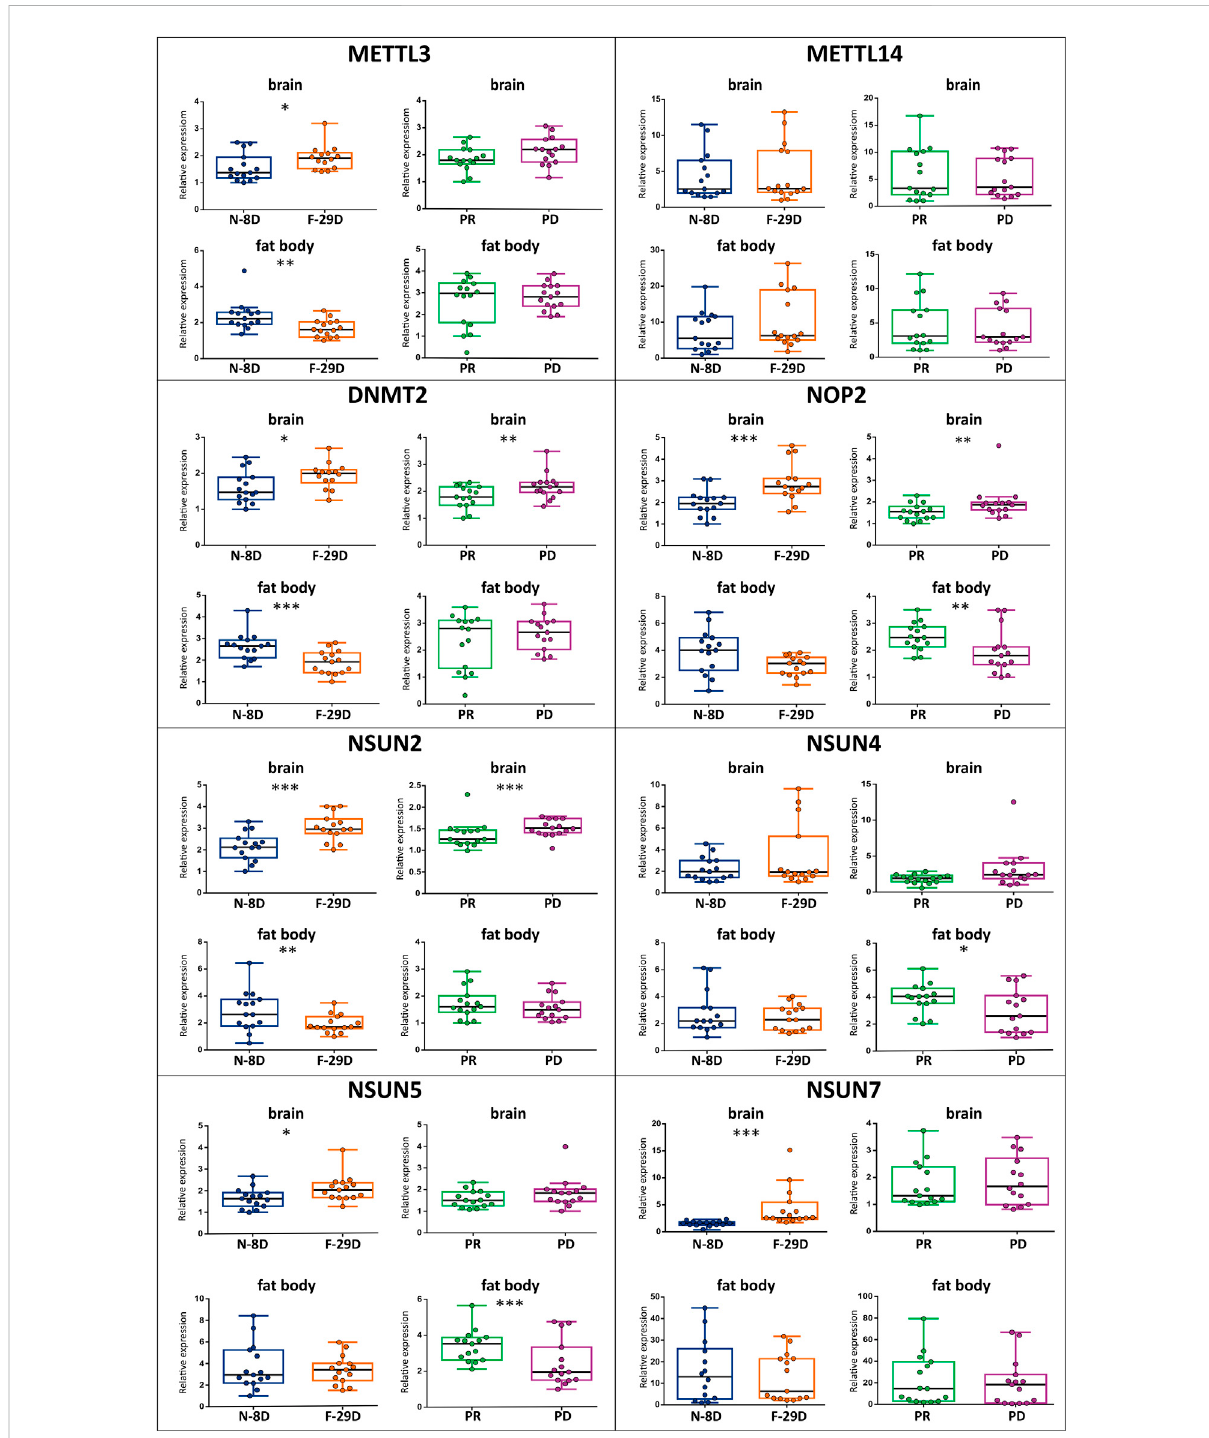
FIGURE 1 Relative expression of m 6 A (METTL3 and METTL14) and m 5 C (DNMT2, NOP2, NSUN2, NSUN4, NSUN5, and NSUN7) RNA methyltransferase genes, measured by real-time PCR in the brain and fat body samples from workers of different ages/behaviors (N-8D for 8 days-old nurses – blue — and F-29D for 29 days-old foragers – orange) and under different dietary regimes (PR for pollen-rich diet – green — and PD for pollen- deprived – purple), n =15percondition.Theboxplotsrepresenttheminimum,maximum,andmedianvalues.Thepresenceofasterisksindicates a signi fi cant difference in expression, * p < 0.05, * p < 0.01, ** p <